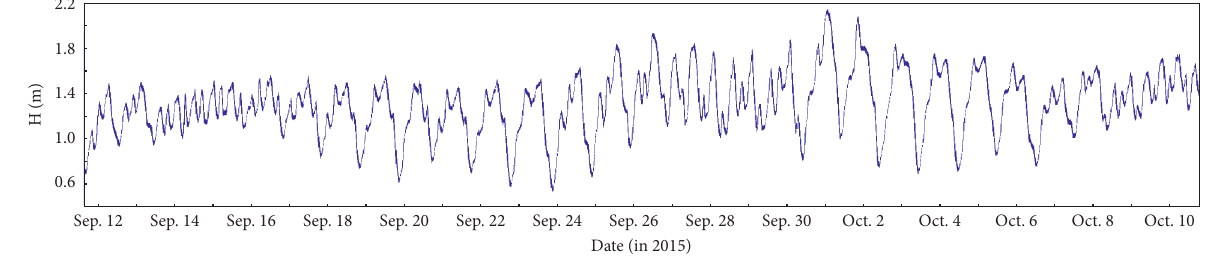
Figure 3: The tide level during Sep.12 to Oc. 10, 2015 in the study